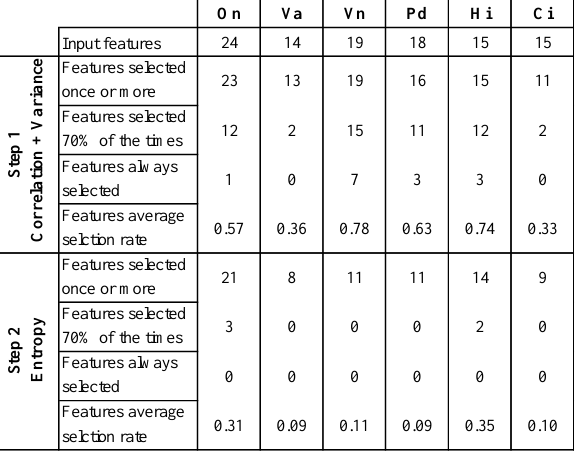
Table 3 . Summary of the features selected considering all the experiments together.